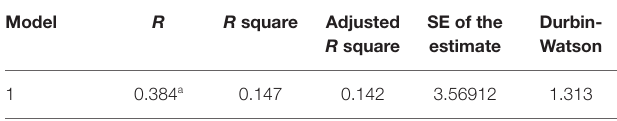
TABLE 3 | Model summary for teachers’ resilience and their emotions.